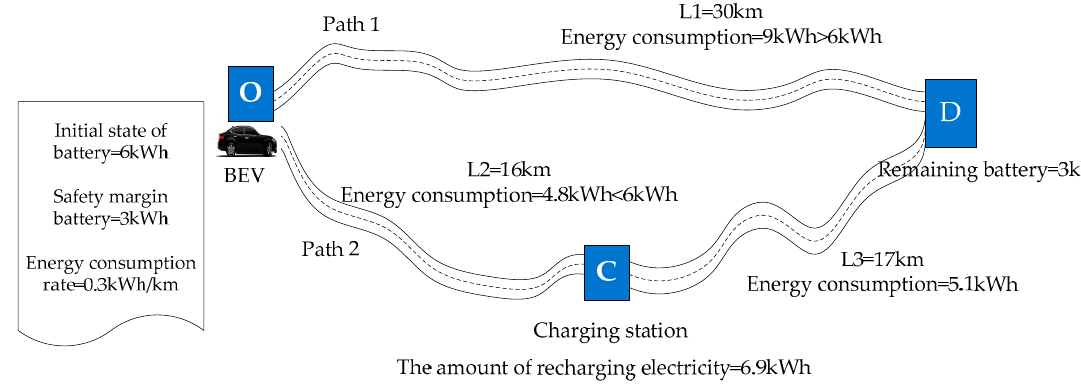
Figure 1. An example of en-route recharging choice behavior.